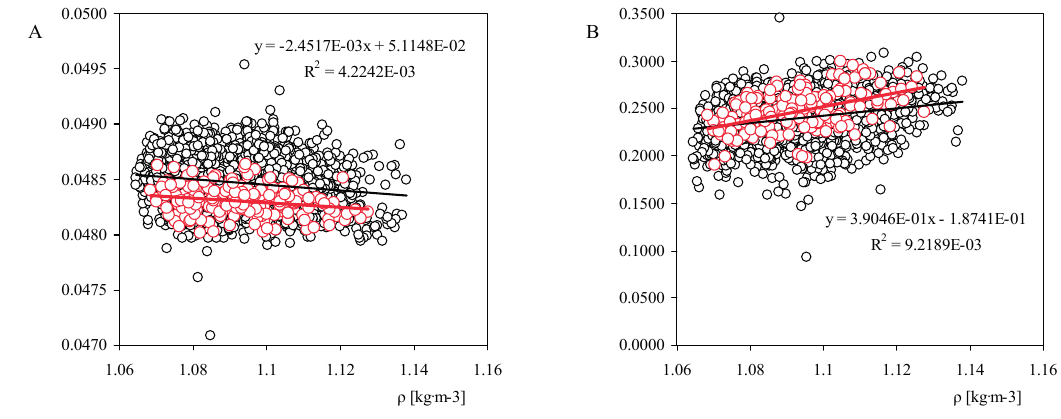
Figure 12. Calibration constants, ( A , B , see Equation (1)), measured for the Thies Clima 4.3350 model anemometers (new anemometers, i.e. , first calibration), as a function of the air density value, ρ , during the calibration process. The data corresponding to the calibrations performed for quality assurance processes on the IDR/UPM Institute Thies Clima 4.3350 anemometer have been also included (red color). The linear fits to both data sets have been also included in the graphs. From